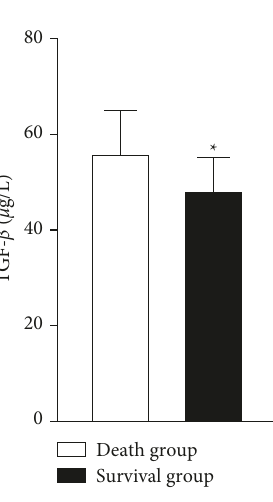
Figure 3: Distribution of TGF- β in survival group and death group.